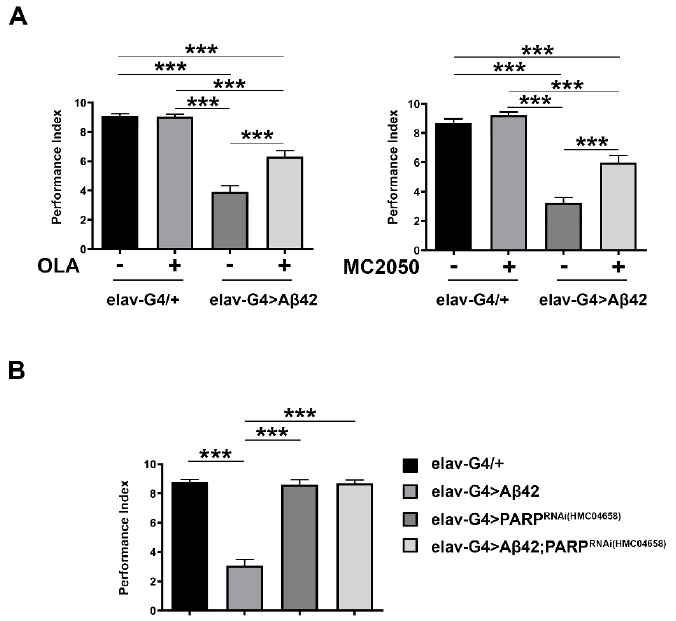
Figure 1. ( A ) Climbing test on elav-Gal4 > A β 42 and elav-Gal4/+ genotypes, in the presence and absence of olaparib and MC2050 PARP-1 inhibitors. Statistical significance was determined using the two-way ANOVA test followed by the Tukey test for multiple comparisons (*** p < 0.001). ( B ) Climbing test on AD A β 42 flies with neuron-specific depletion of PARP-1 by RNAi. Statistical significance was determined using the one-way ANOVA test followed by the Tukey test for multiple comparisons (*** p <0.001).